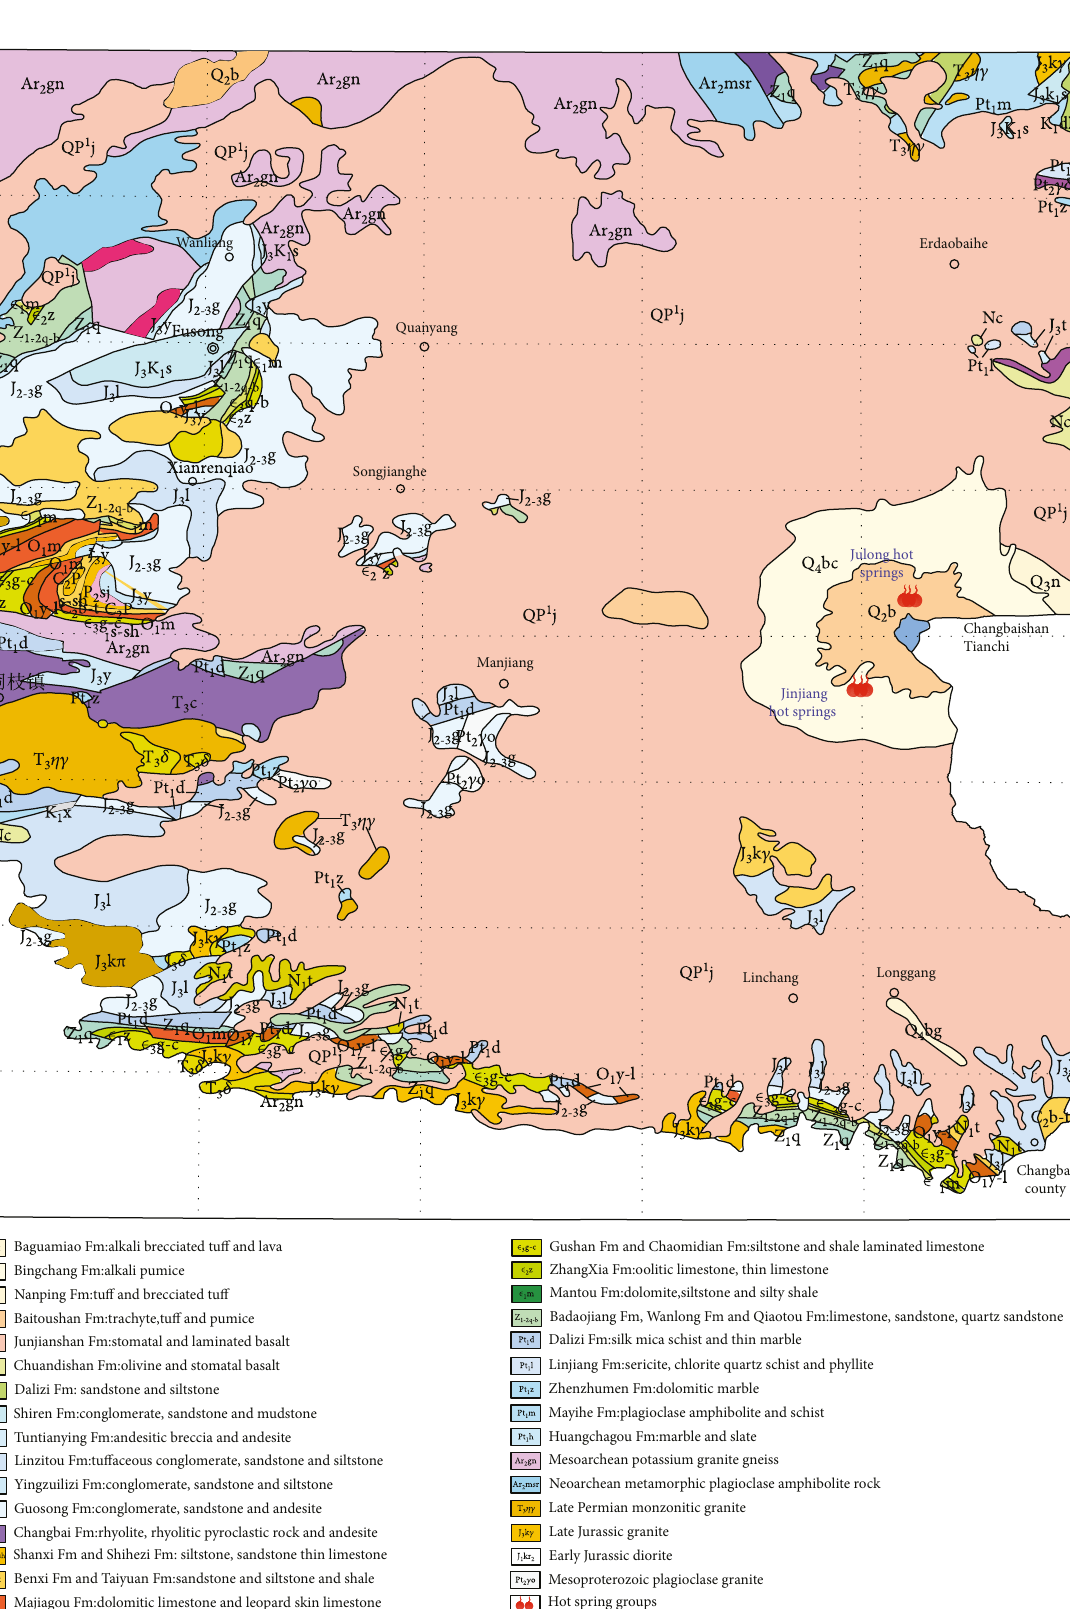
Figure 1: Geological map of the Changbai Mountain